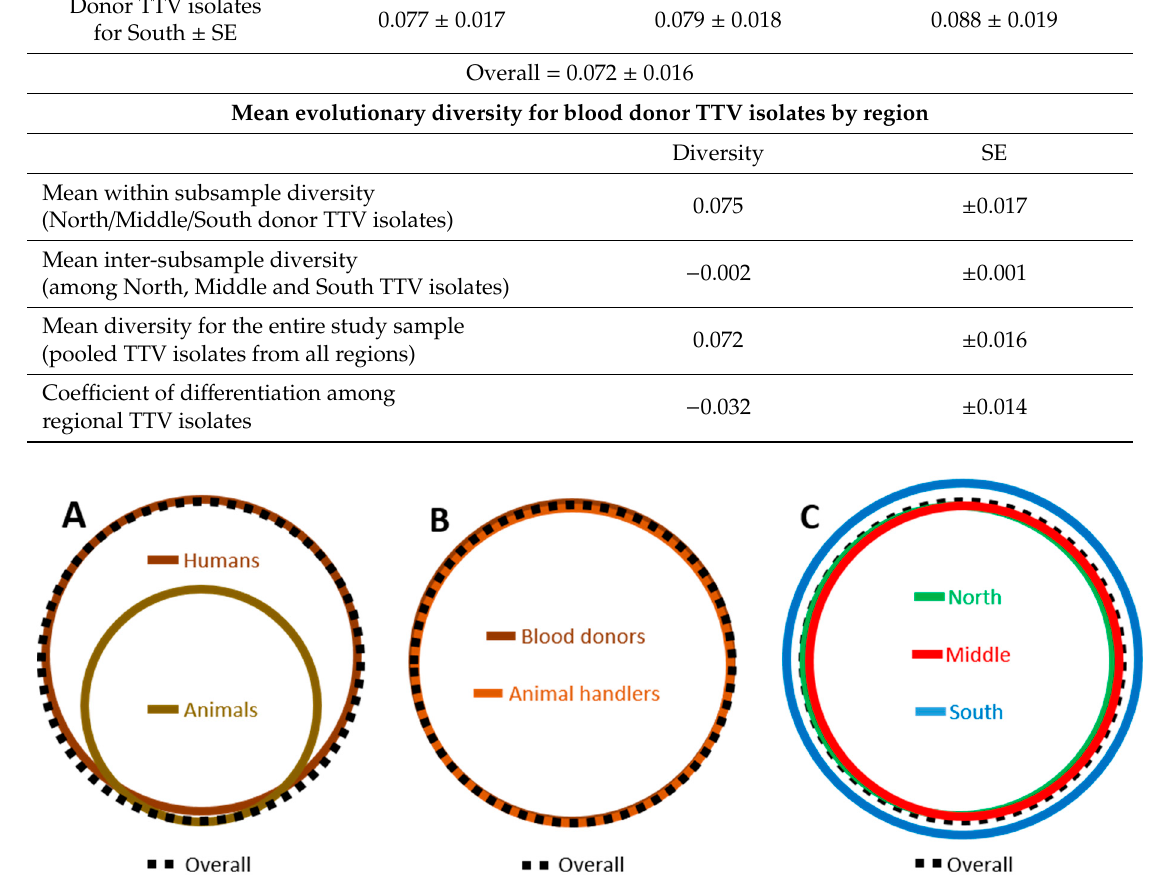
Figure 4. A schematic representation of the 5 ′ -UTR sequence evolutionary distance and diversity analyses. Panels ( A – C ) represent Tables 5–7, respectively. The area of each circle is proportional to the mean pairwise evolutionary distance.